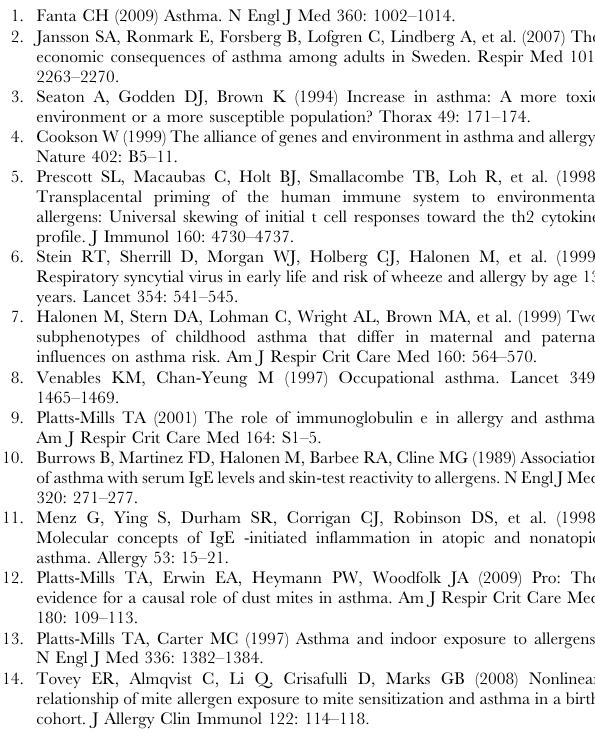
Table S1 List of arrayed allergens grouped according to their source. Table S2 Partition assessment analysis at different k values. Table S3 The case-control group. Table S4 Cluster distribution of case-control reactivity profiles. Table S5 Segregation of family members in the clus- ters. Table S6 List of asthma relevant allergens.